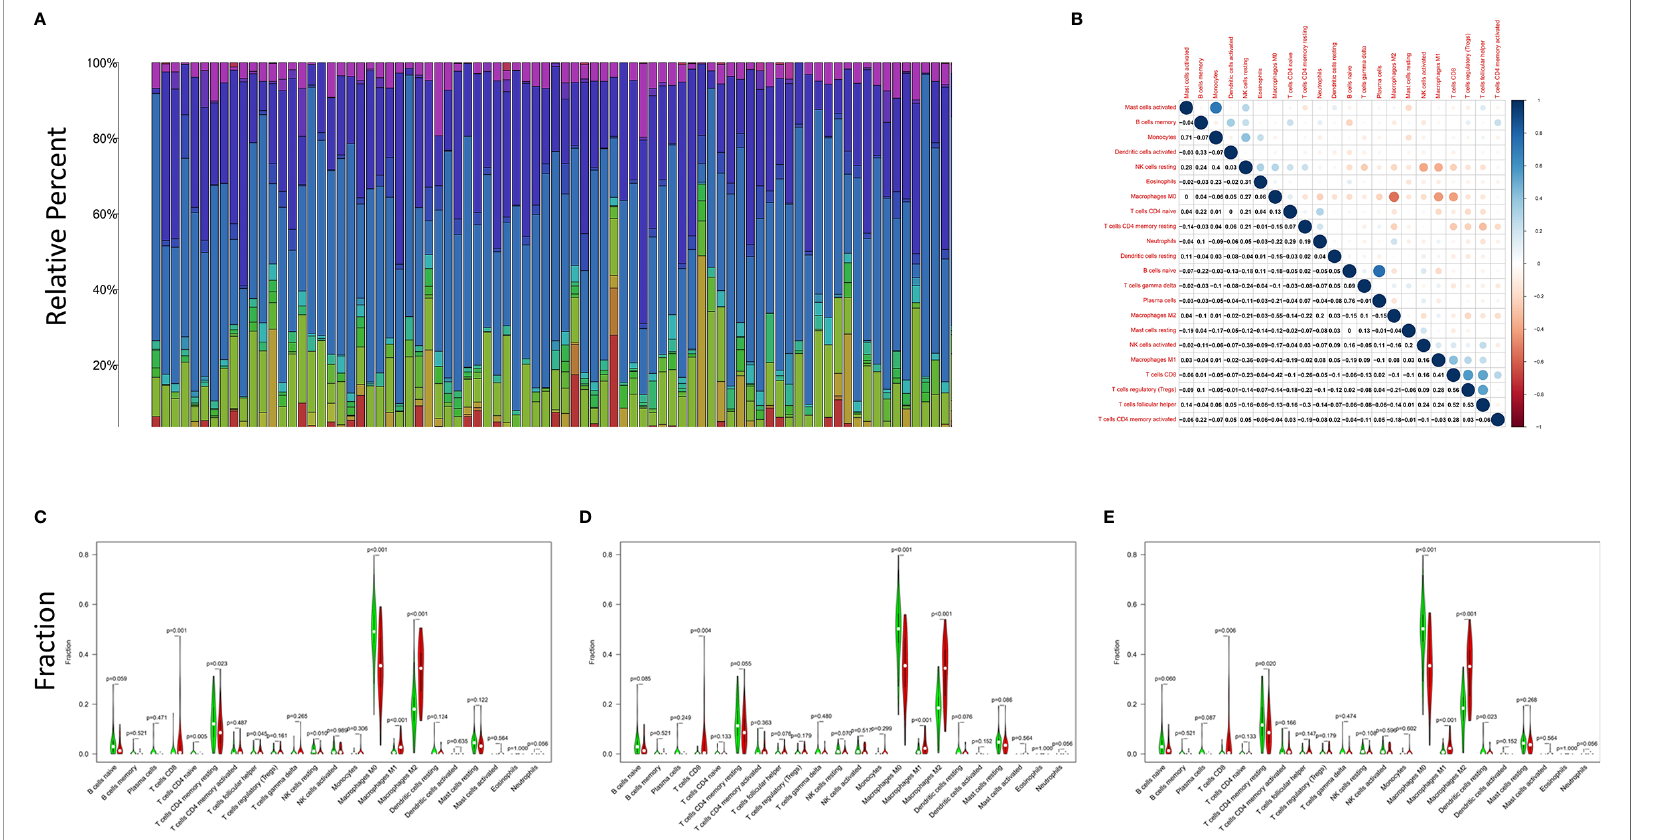
FIGURE 7 | TIC pro fi les of tumor samples from OS patients and correlation analyses. (A) The proportions of 22 types of TICs among the tumor samples from OS patients are shown in the bar chart. Sample IDs are used as the names of column. (B) The correlations among the 22 types of TICs in the different OS samples are indicated in the heatmap with the p values (number in each box) of the correlations between two cells shown. The corresponding correlation values (shade of each colored box) are displayed, and signi fi cance was evaluated using the Pearson correlation coef fi cient. (C – E) The differences in 22 kinds of TICs between the high and low C1qA, C1qB and C1qC expression groups are shown in the violin plot. The Wilcoxon rank-sum was applied to test signi fi cance. The TIC names are shown on the X-axis, and the contents are indicated on the